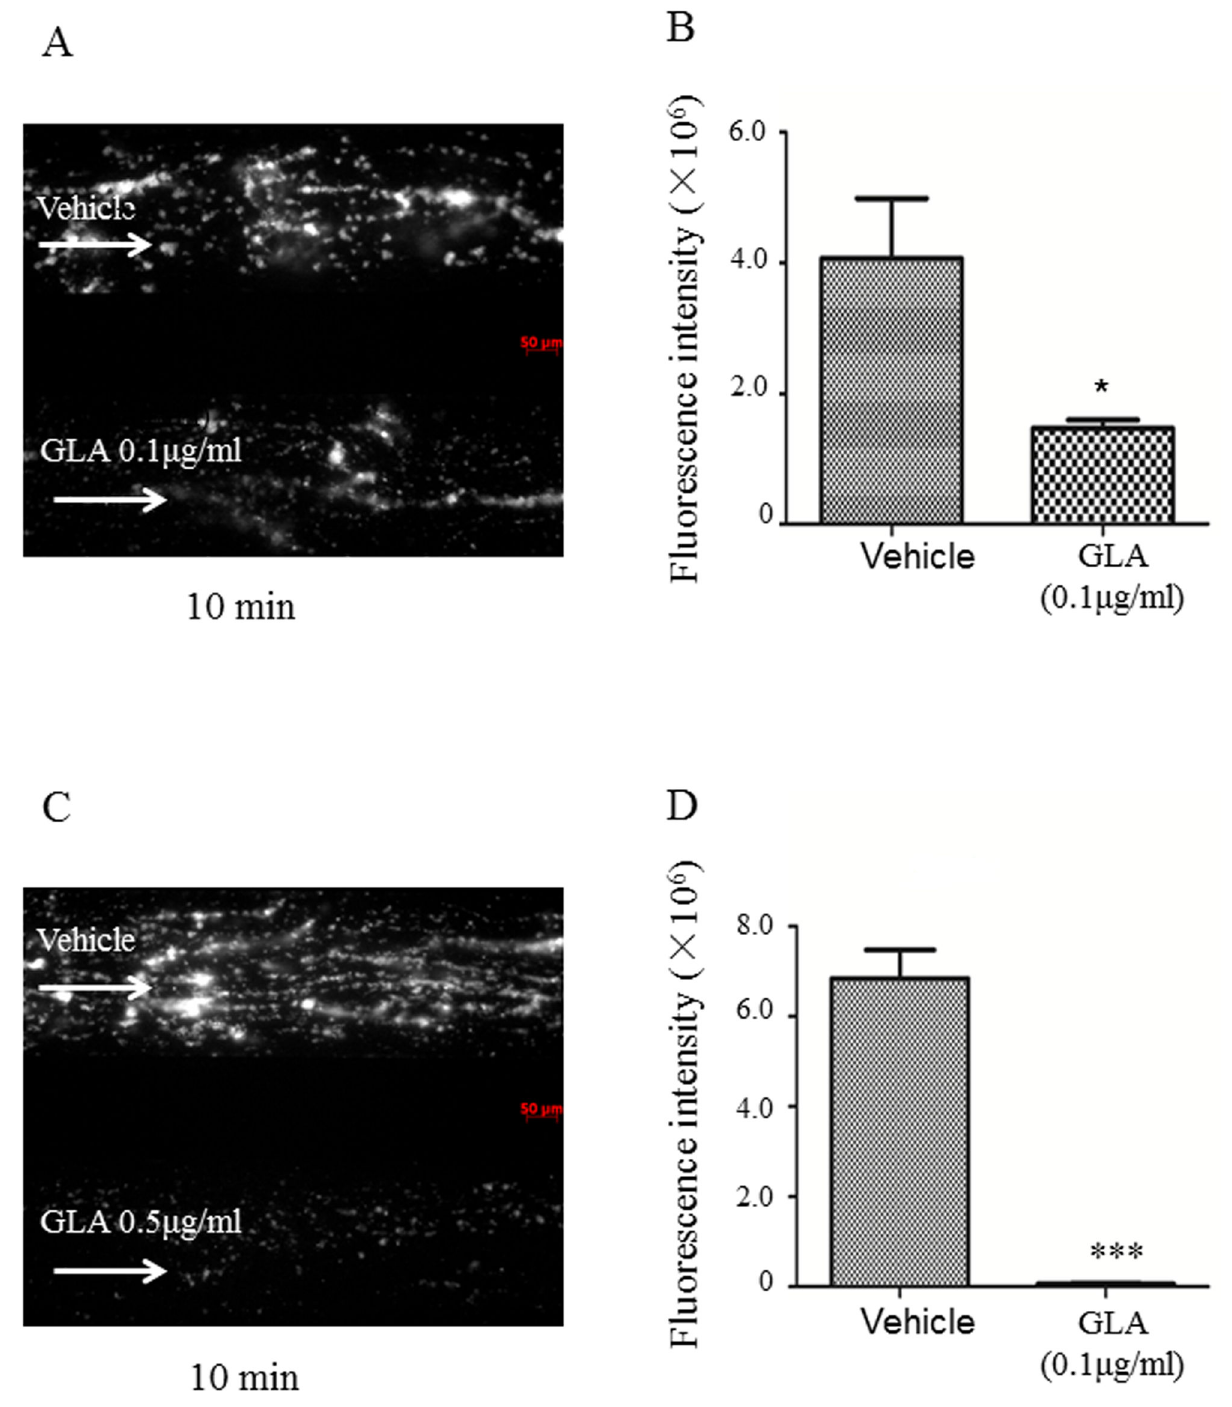
Figure 7. Effects of GLA on platelet adhesion on collagen-coated surfaces. H uman whole blood was labeled with Calcein-AM, treated with (lower channels) or without (upper channels) 0.1μg/ml (A) or 0.5μg/ml (B) of GLA, and perfused over collagen-coated surface for 30 min at a shear rate of 40 dyn/cm 2 (1000s -1 ). Platelet adhesion and aggregates were observed under a fluorescence microscope. Photos were taken at 10min (A) after flow. Arrow indicates the flow direction. Data plotted are means ± standard errors of fluorescence intensity of three individual experiments (*P < 0.05, ***P < 0.01). The Student t test was used to calculate P values for differences.